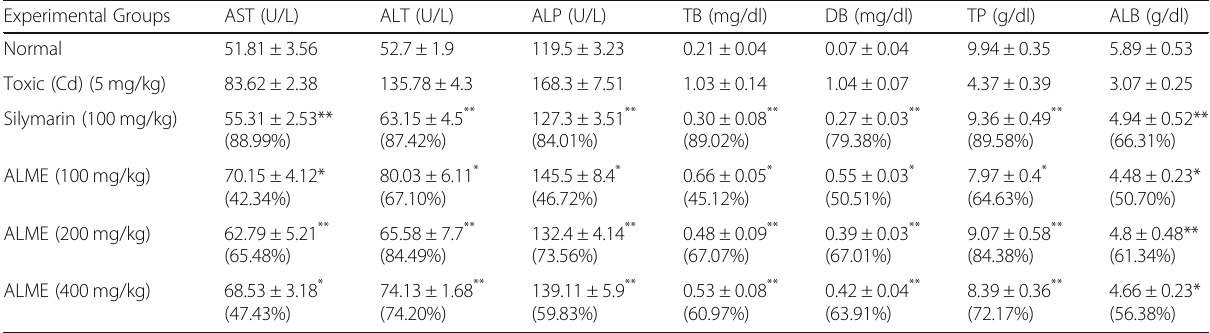
Table 1 Hepatoprotective effect of ALME on different biochemical parameters in cadmium induced liver damage in rats Experimental